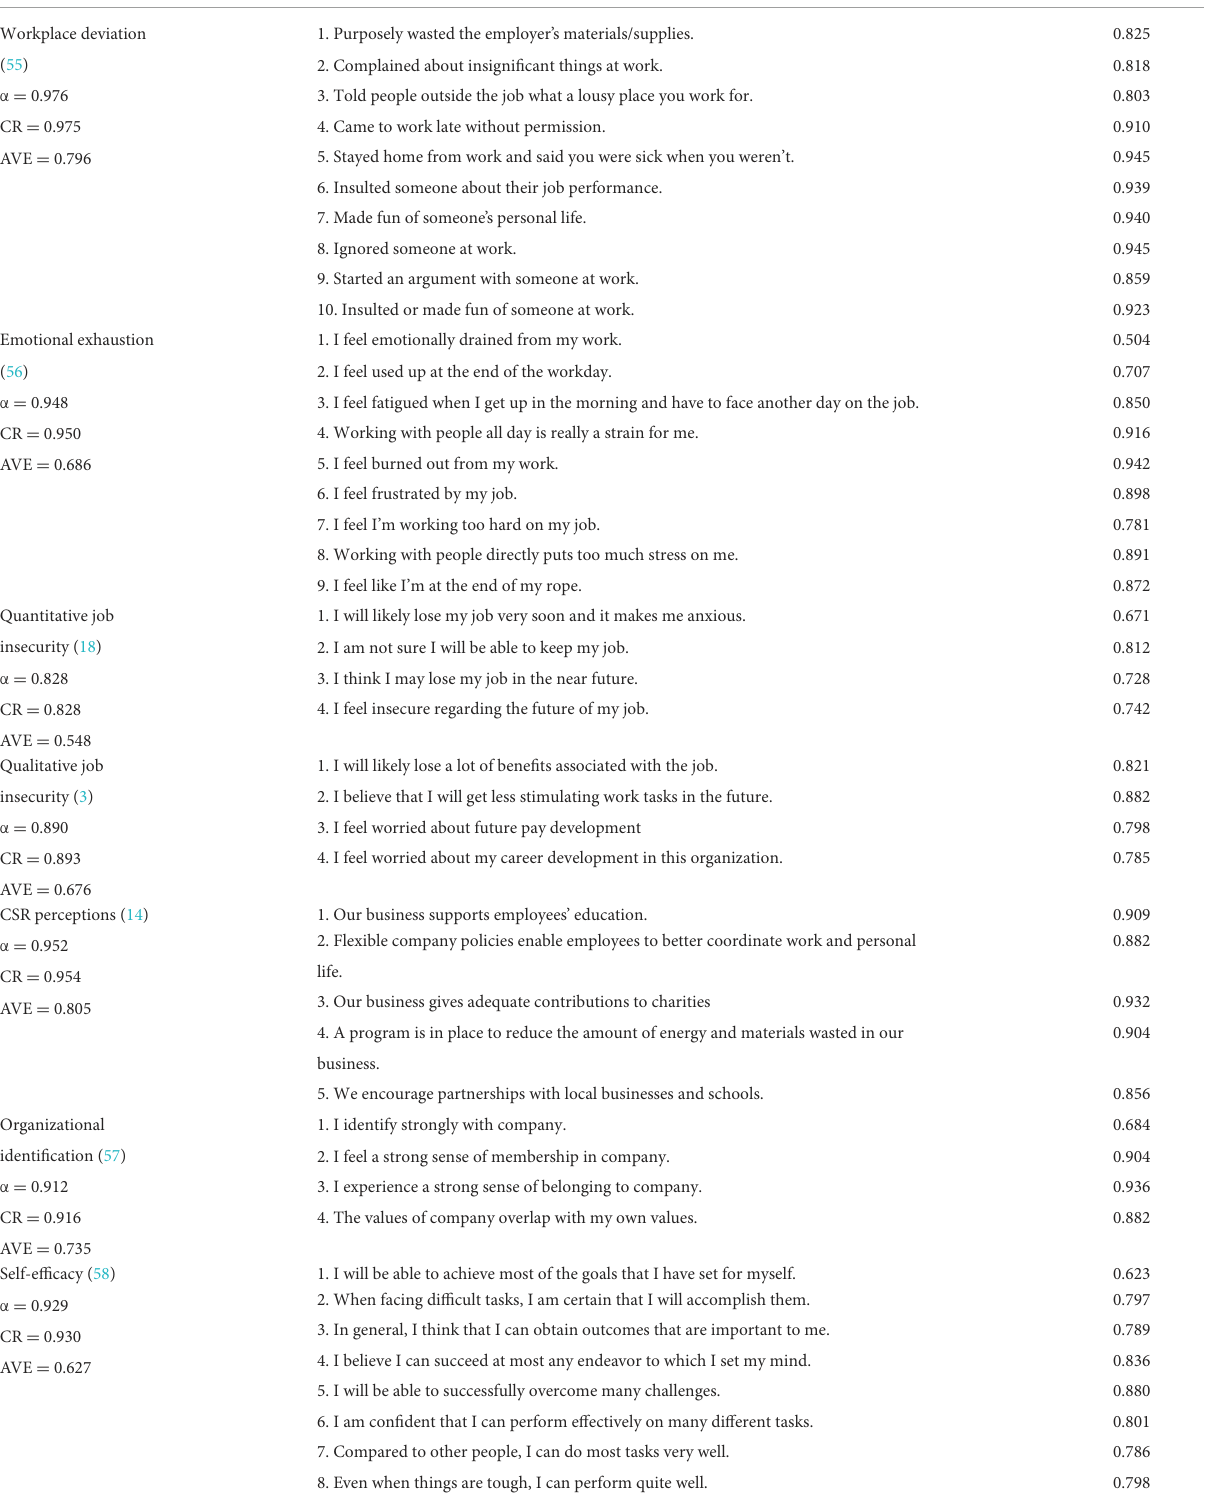
TABLE 1 Confirmatory factor analysis